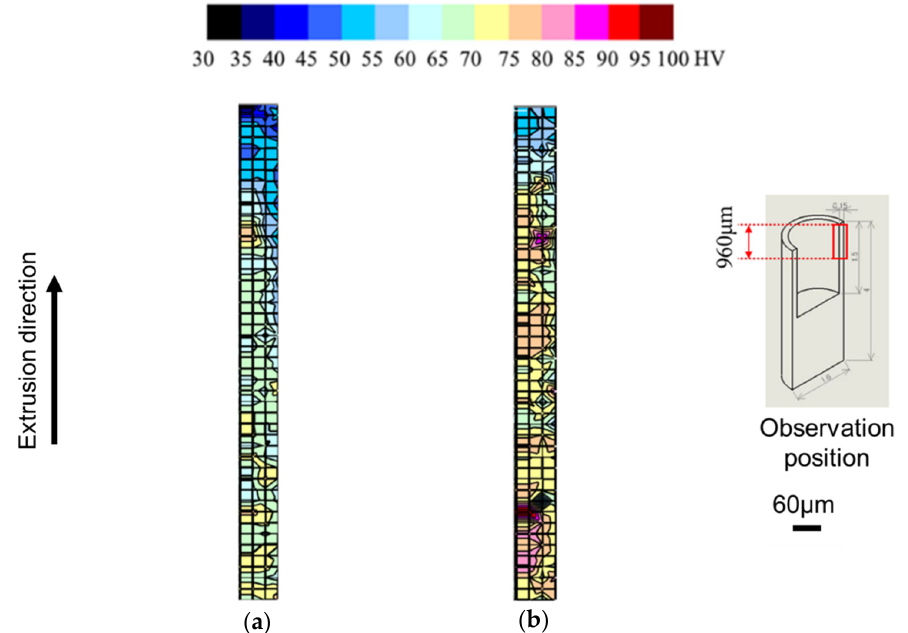
Figure 10. Distribution of the Vickers hardness of the extrusion: ( a ) mirror surface punch; and ( b ) grooved punch (depth 5 µm).